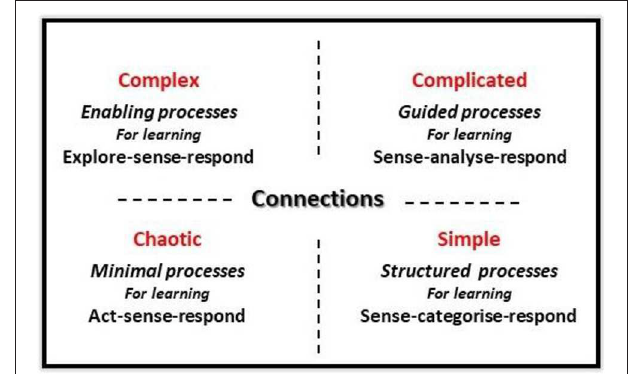
FIGURE 3 | Frame of reference. Reproduced with permission from Freestone and Mason (2019), inspired by the Cynefin Framework (Snowden, 2010).